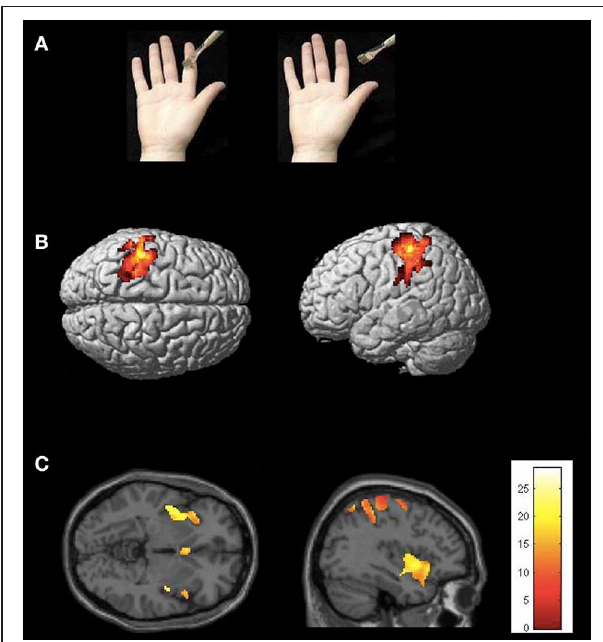
FIGURE 1 | (A) Conditions and types of stimuli used in the experiment. The picture on the left depicts the experimental condition (touch to a hand); the picture on the right shows the control condition (the paintbrush does not hit the depicted hand). (B) Statistical map showing common brain activation in left SI for receiving real touch ( > resting baseline) and observing touch ( > control) (random-effects analysis, p < 0 . 05, FWE corrected). (C) Statistical map demonstrating activation in insula (and other brain areas, masked with real touch > baseline). Areas of significant fMRI signal change are shown as color overlays on the T1-MNI reference